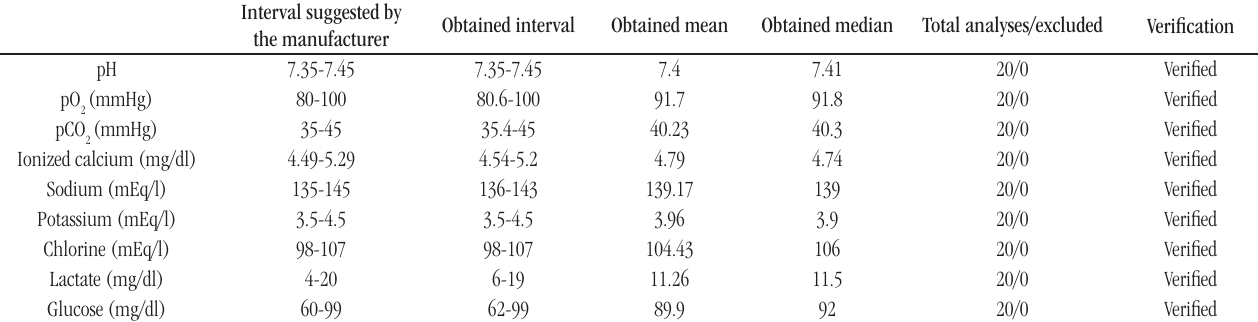
taBLE 5 − Verification of reference values in individuals considered healthy for venous blood